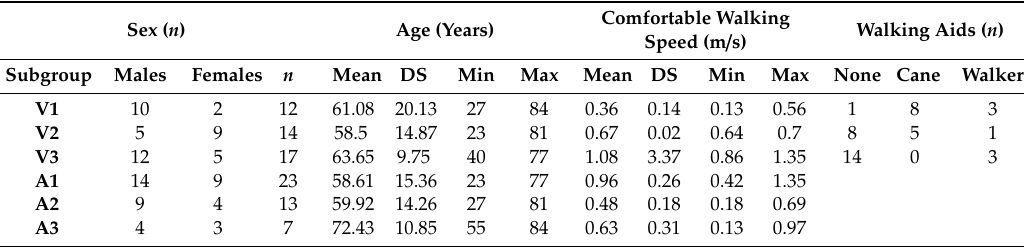
Table 1. Sex distribution, age, comfortable walking speeds, and walking aids used by groups V1, V2, and V3 and A1, A2, and